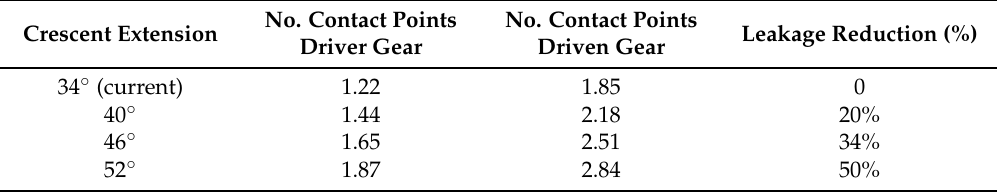
Table 4. Influence of the mean number of contact points on the tooth tip leakage.